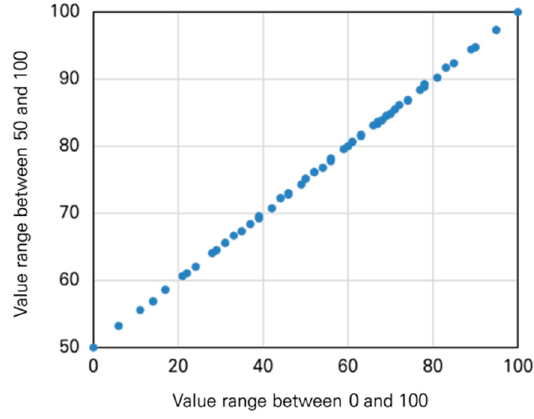
Figure 3. The correlation between two different value ranges.